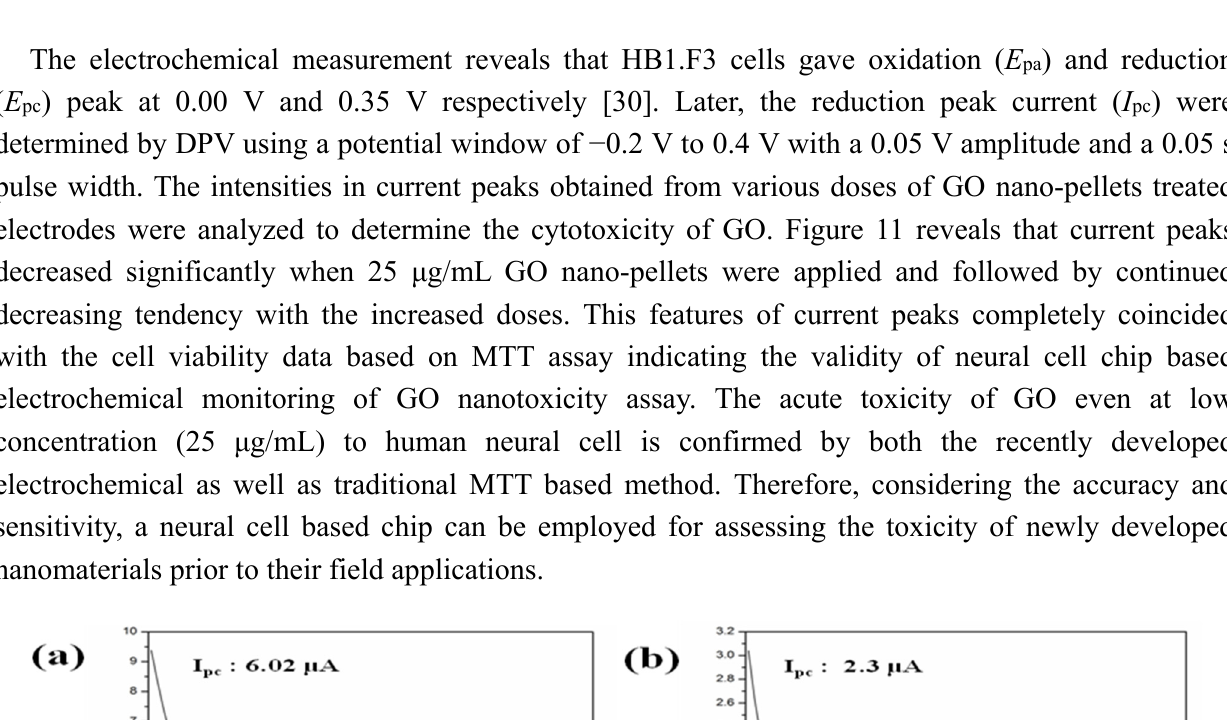
Figure 10. Schematics for the electrochemical detection of the toxic effect of Graphene oxide (GO) on human neural stem cell (HB1.F3). Reproduced with permission from [30], Copyright 2012, American Scientific